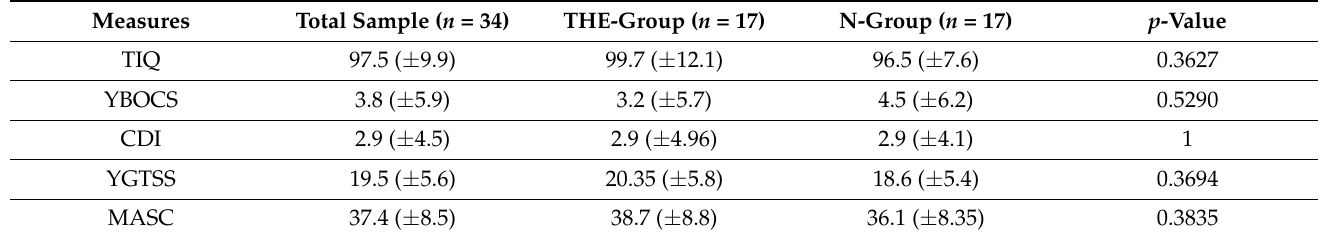
Table 2. Neuropsychological findings of the TS patients at baseline (T0).